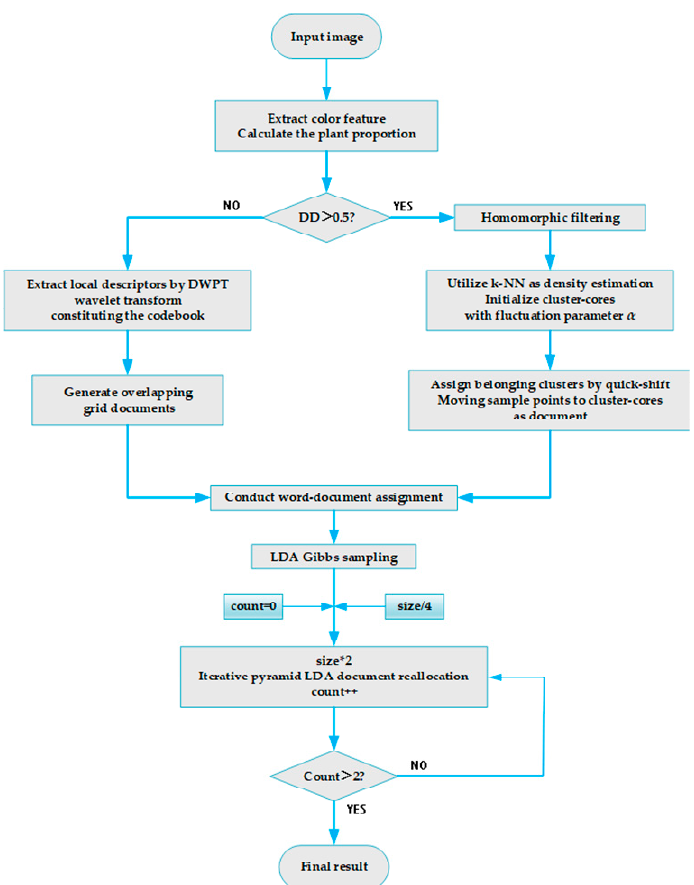
Figure 14. The flowchart of self-adaptive iterative latent Dirichlet allocation algorithm (SAI-LDA). DD is the distance determination; DWPT is discreet wavelet packet transform.